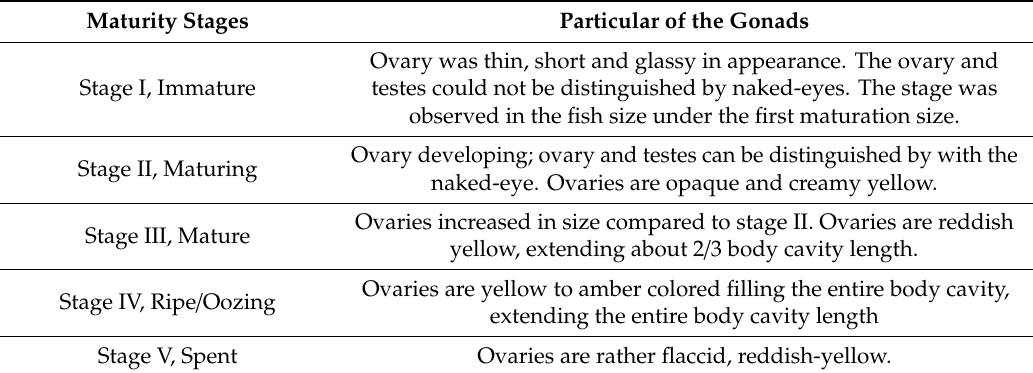
Table 1. Maturity stages of female blue tang fish